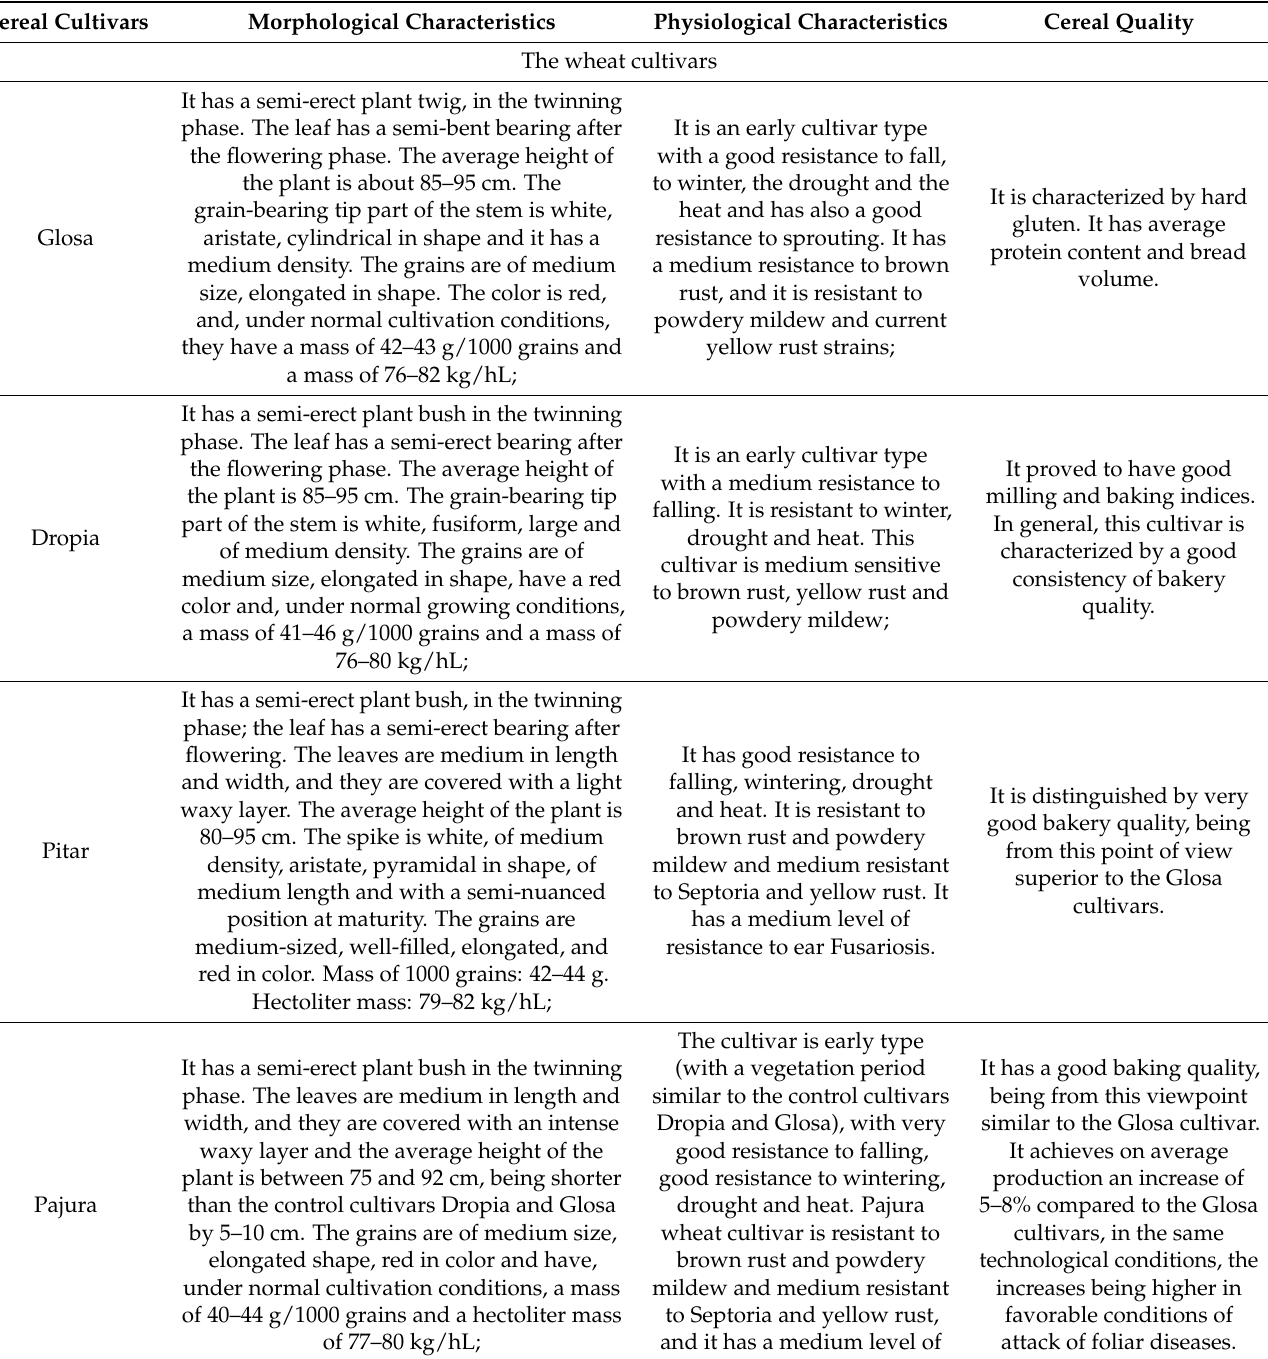
Table 1. The morphological and physiological characteristics of the wheat cultivars ( Triticum aestivum L.) and barley cultivars ( Hordeum vulgare L.)